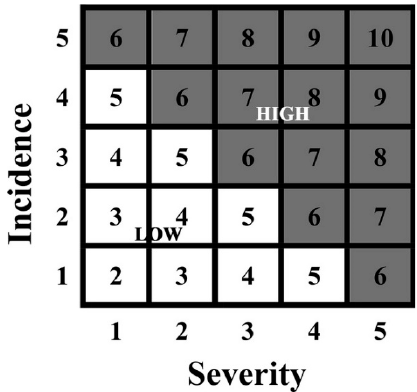
Figure 2. Risk perception matrix.